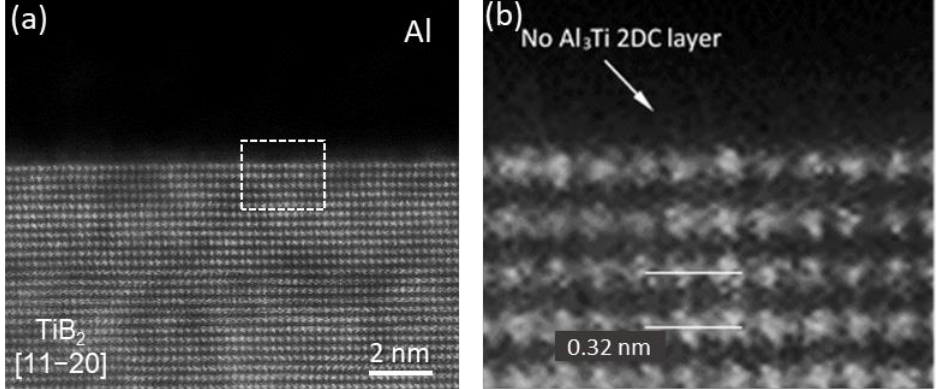
Figure 18. Disappearance of Al 3 Ti 2DC at Al/TiB 2 interface in Al-Si melt [30]. High resolution STEM- HAADF images of ( a ) Al/TiB 2 interface and ( b ) zoom of the marked local region across the interface viewed along [1 1 2̅ 0]TiB 2 direction for a TiB 2 particle (by addition of Al-5Ti-1B grain refiner) in Al-8.4Si alloy melt, showing that the pre-existing Al 3 Ti 2DC layer on the (0 0 0 1)TiB 2 surface is no longer there.